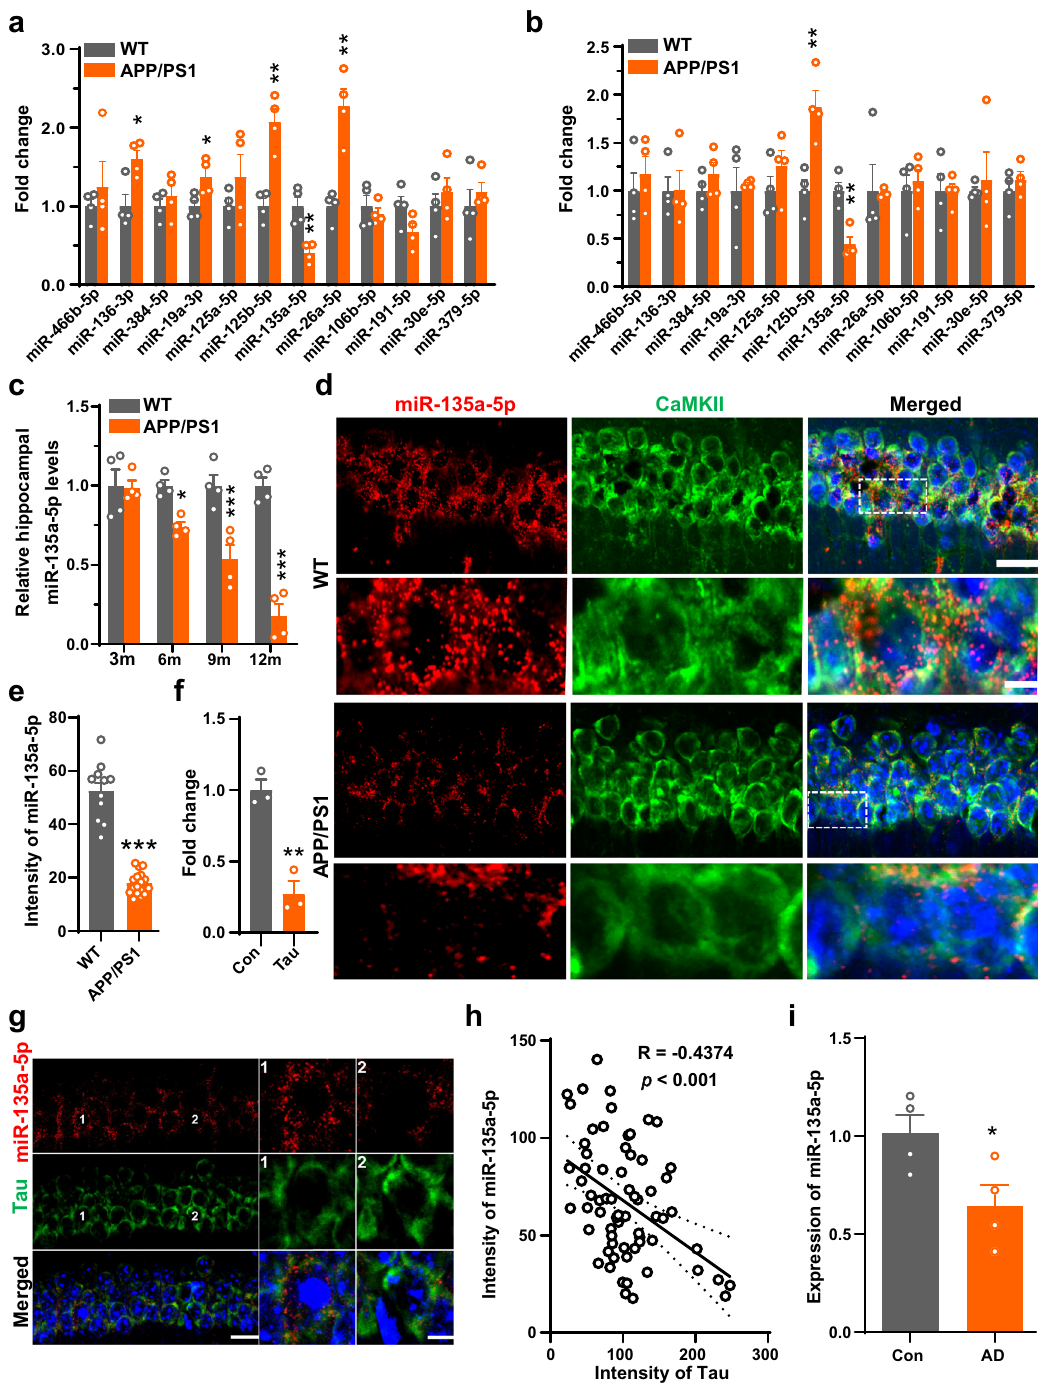
Fig. 1 Alteration of synaptic activity-associated miRNAs in the hippocampus of AD mice. a , b Fold changes of synaptic activity associated with microRNAs (miRNAs) in the hippocampus of 12-month-old ( a ) or 9-month-old ( b ) APP/PS1 and control mice (WT) ( n = 4 for each group). c Relative expression of miR- 135a-5p in the hippocampus of APP/PS1 and control mice (WT) at different months as indicated ( n = 4 for each group, two-way ANOVA, p <0.0001). d The distribution of miR-135a-5p in glutamatergic excitatory neurons in hippocampal slices of 9 months APP/PS1 and control mice (WT) by co-immuno fl uorescence experiments with the antibody of CamKII (Green) and FISH of miR-135a-5p (Red). The ampli fi cation images were shown at the bottom of each group. Scale bar = 20 μ m (upper), 5 μ m (lower) ( n = 3 for each group). e Quanti fi cation of fl uorescence intensity for miR-135a-5p in CaMKII positive neurons from ( d ) ( n = 11, 17 for WT, APP/PS1, p <0.0001). f qRT-PCR was used to evaluate the expression of miR-135a-5p in the primary culture neurons at DIV 10 after overexpression of AAV-hTau (Tau) or control virus (Con) for 72h ( n = 3 for each group). g A representative immuno fl uorescence staining of FISH for miR- 135a-5p (Red) and immuno fl uorescence experiments with the antibody of Tau-5 (Tau, Green) in hippocampus of 9 months APP/PS1 mice. Scale bar = 20 μ m (left), 5 μ m (right). h The fl uorescence correlation of intensities of miR-135a-5p and Tau-5 in APP/PS1 mice as shown in panel ( g ) ( n = 68 neurons from 5 mice). i The expression of miR-135a-5p in the frontal cortex from patients with AD and age-matched controls was measured by qRT-PCR ( n = 4 for each group). (Data are presented as mean±S.E.M. and two-tailed t tests were used unless otherwise speci fi ed. Source data are provided as a Source Data fi le. * p < 0.05, ** p <0.01, *** p <0.001 vs.